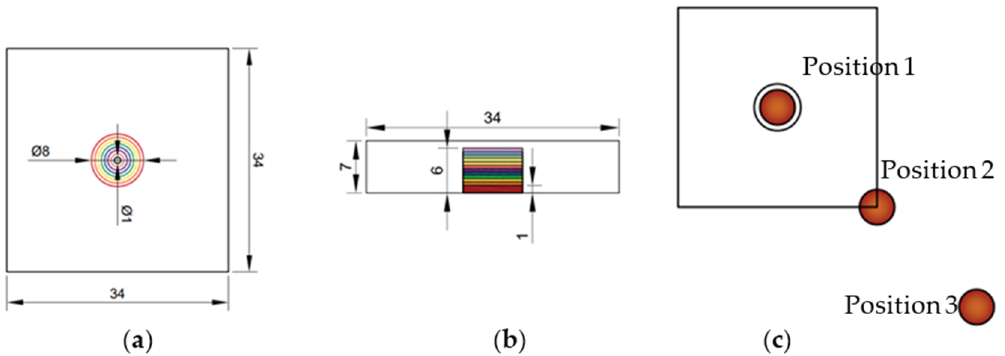
Figure 5. The parameterization of the numerical model. ( a ) Chosen defects diameters, ( b ) chosen defects’ depths, and ( c ) positions of the center of the heating source.